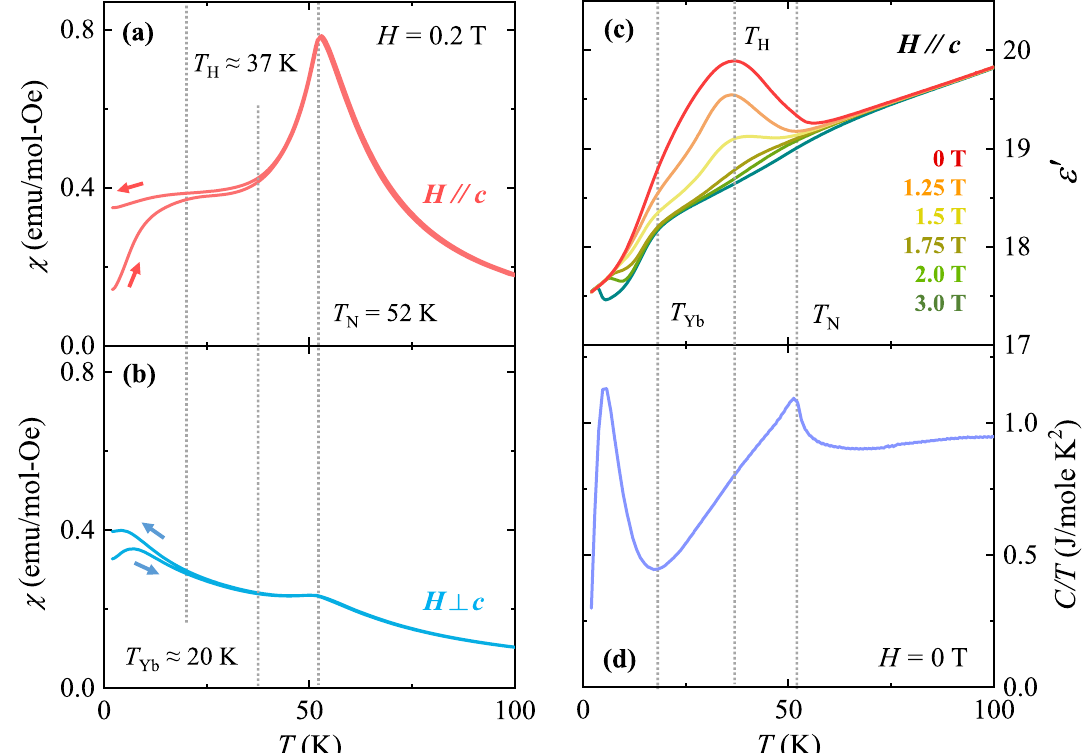
Figure 1. Temperature-dependent physical properties of Yb 2 CoMnO 6 (YCMO). ( a ) and ( b ) Temperature dependence of magnetic susceptibility, χ = M / H , of the YCMO crystal at H = 0.2 T upon warming after zero- magnetic-field cooling and upon cooling in the same field along and perpendicular to the c axis, respectively. The vertical dotted lines represent the ordering temperature forming ↑↑↓↓ -type spin state ( T N = 52 K), onset temperature of magnetic hysteresis ( T H ≈ 37 K), and ordering temperature of Yb 3+ moments ( T Yb ≈ 20 K). ( c ) Temperature dependence of dielectric constant ( ε ′ ), measured perpendicular to the c axis at H = 0, 1.25,